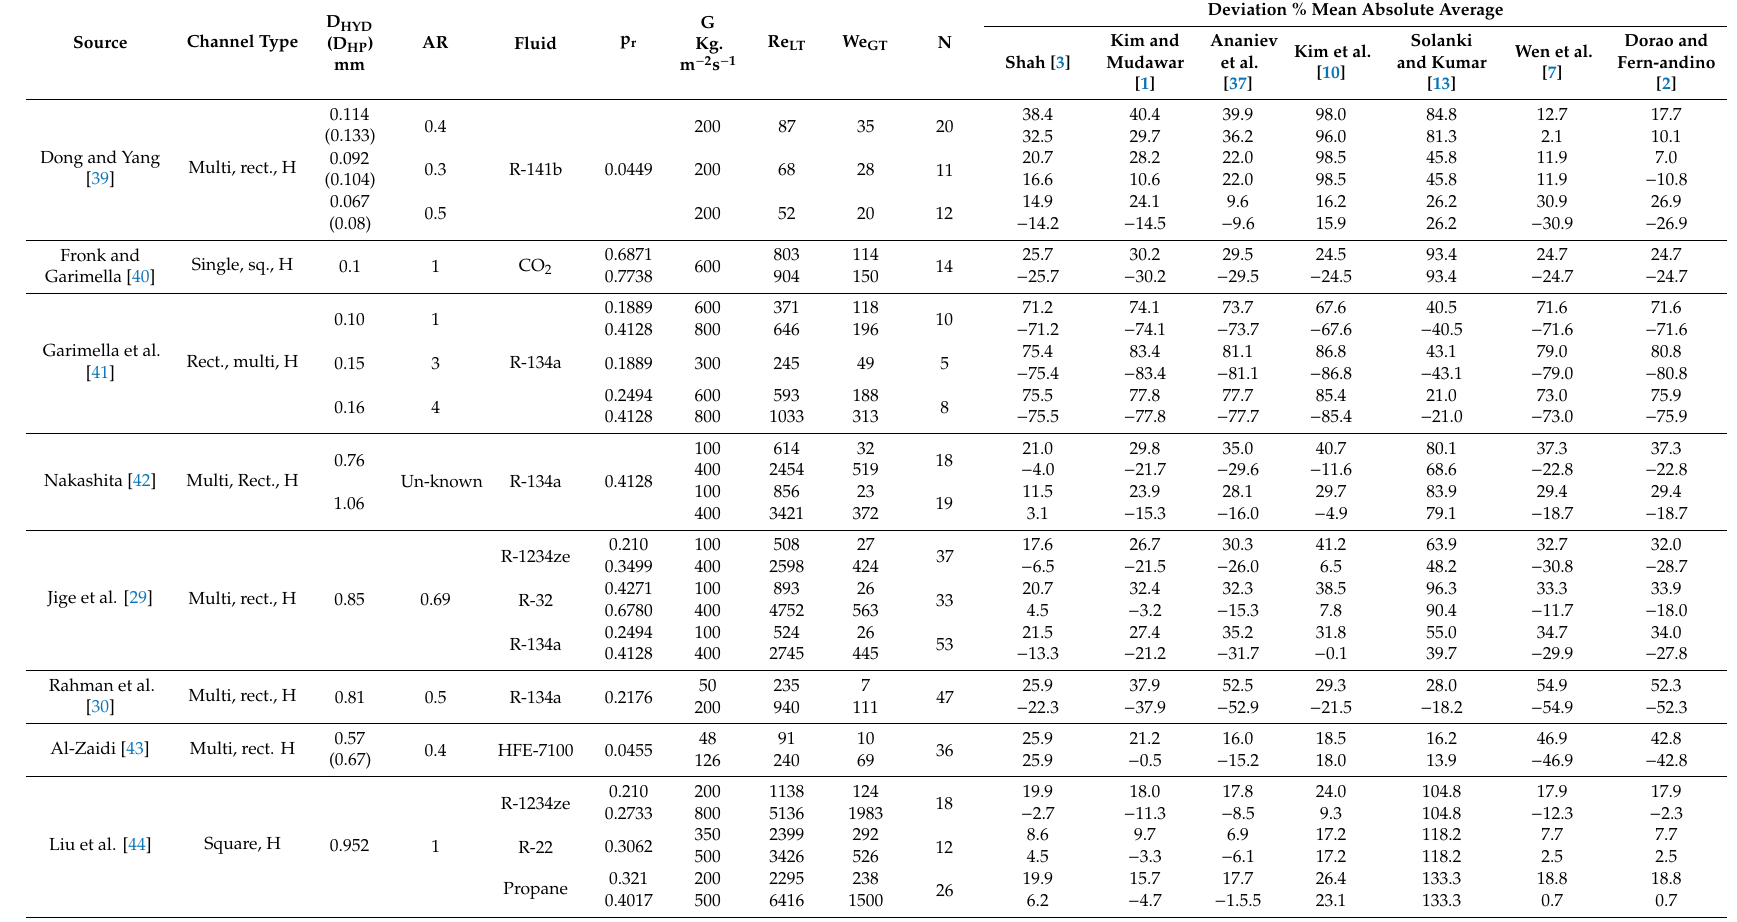
Table 2. Deviations of various correlations with data for non-circular channels other than flattened